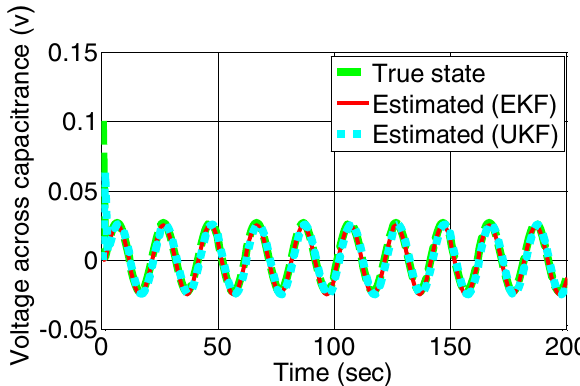
Figure 7. Voltage across charge transfer capacitance estimated by EKF and UKF during charging.